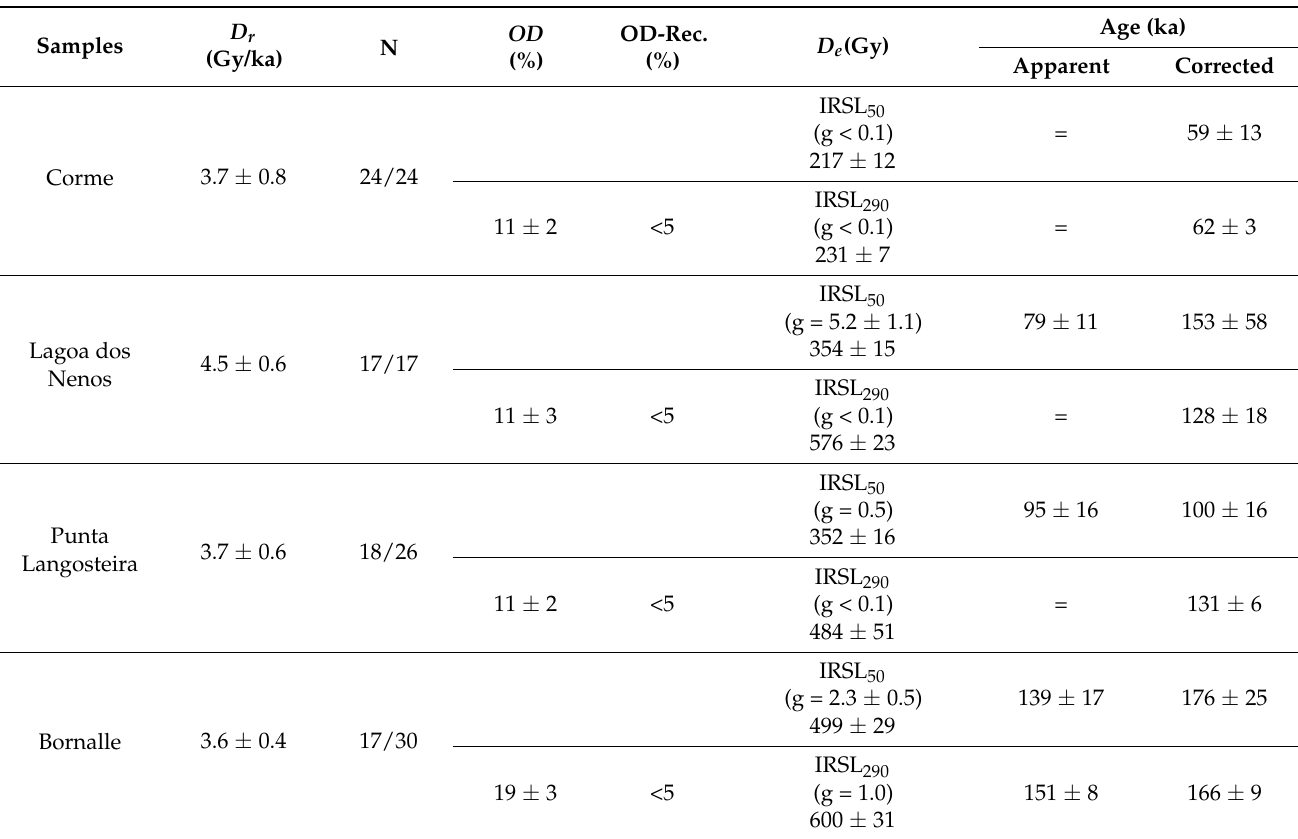
Table 2. D e s and corrected ages. D r , the corrected dose rate; N, the number of aliquots ac- cepted/analysed; OD , the percentage of overdispersion; OD-Rec., the percentage of overdispersion from the recovery test; D e , the equivalent dose estimated by the CAM model. The estimated fading values ( g -value = g) for the IRSL 50 and IRSL 290 signals are indicated: Age, apparent and corrected age (ka, kiloannum = 1000